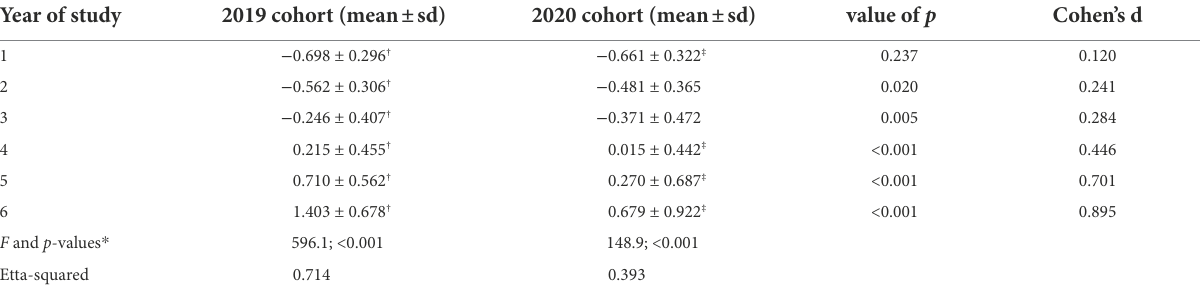
TABLE 1 Measures of knowledge calculated by the Rasch model for each year of study in 2019 and